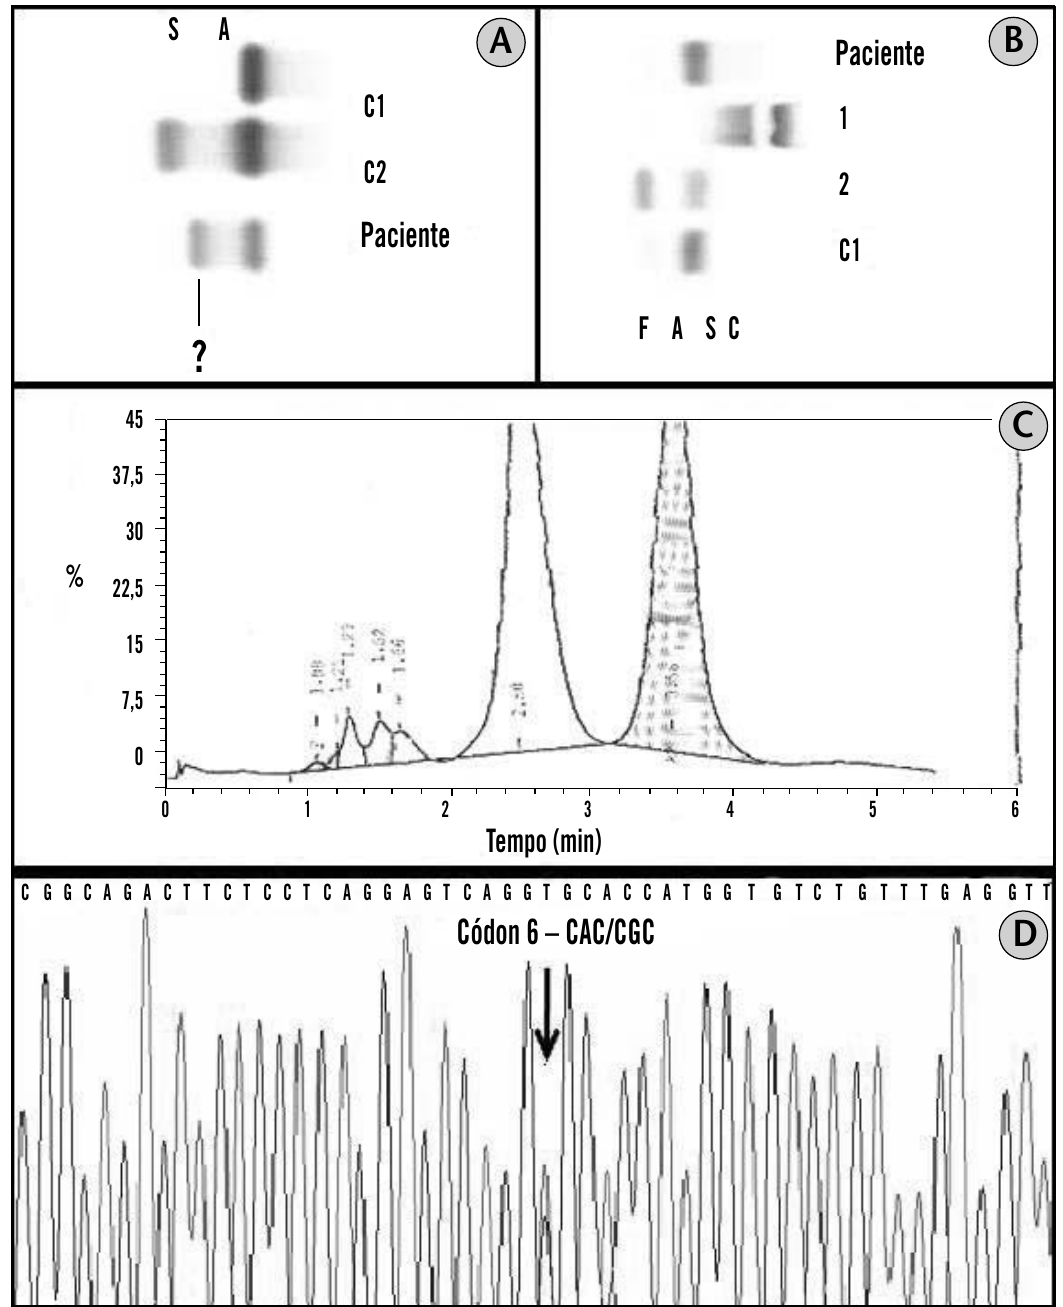
Hb ( Figura 3C ). Para o diagnóstico definitivo, aplicou-se técnica molecular de sequenciamento, que detectou a troca de um aminoácido histidina (His) por arginina (Arg) no códon 6, em heterozigose, compatível com Hb Deer Lodge ( Figura 3D ).